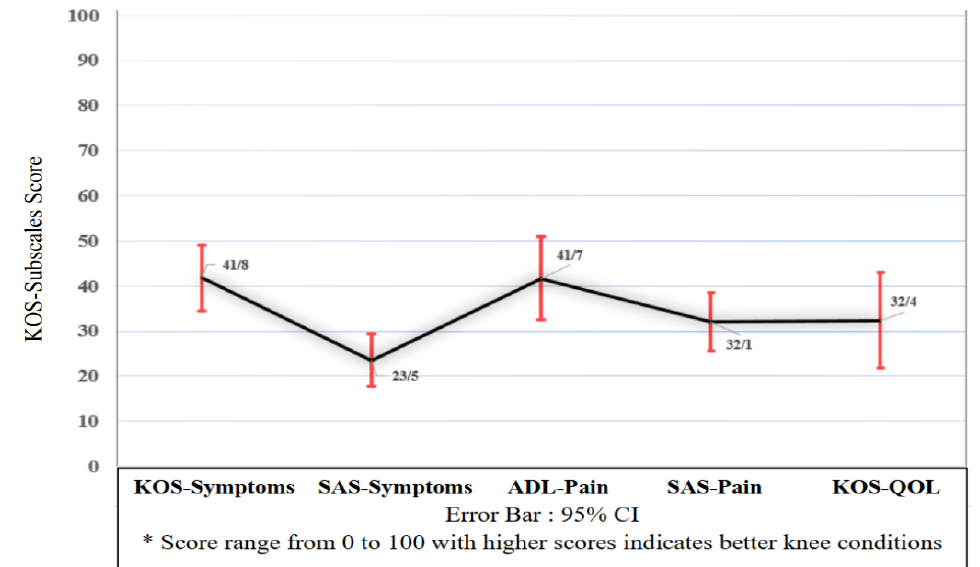
Figure 3. KOS-Subscales Score related to the quality of life, pain, and symptoms in daily and sports activities. Abbreviation: KOS: Knee Outcomes Survey, SAS: Sport Activity Scale, ADL: Activity of Daily Living, QOL: Quality of Life.